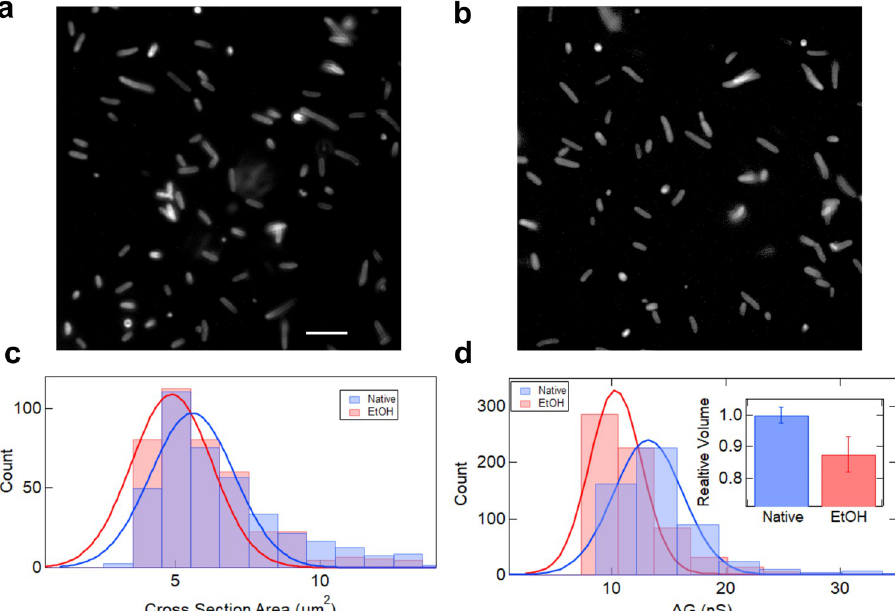
Fig 6. Measurement of changes in bacterial relative volumes using lab amplifier. a and b are flourescent images of DH5 α strain of E. coli bacteria in 1X PBS buffer with and without ethanol exposure respectively (scale bar is 10 μ m). The histogram in c shows the projected area estimated from the fluorescent images for bacterial cells. d compares the Δ G histograms of E. coli cells measured in a 2.1 μ m micropore device. The inset is a bar plot showing relative change in cell volumes when cells are treated with 5% (v/v) ethanol when compared to their native state in 1X PBS buffer (average of 4 experiments). Online version in